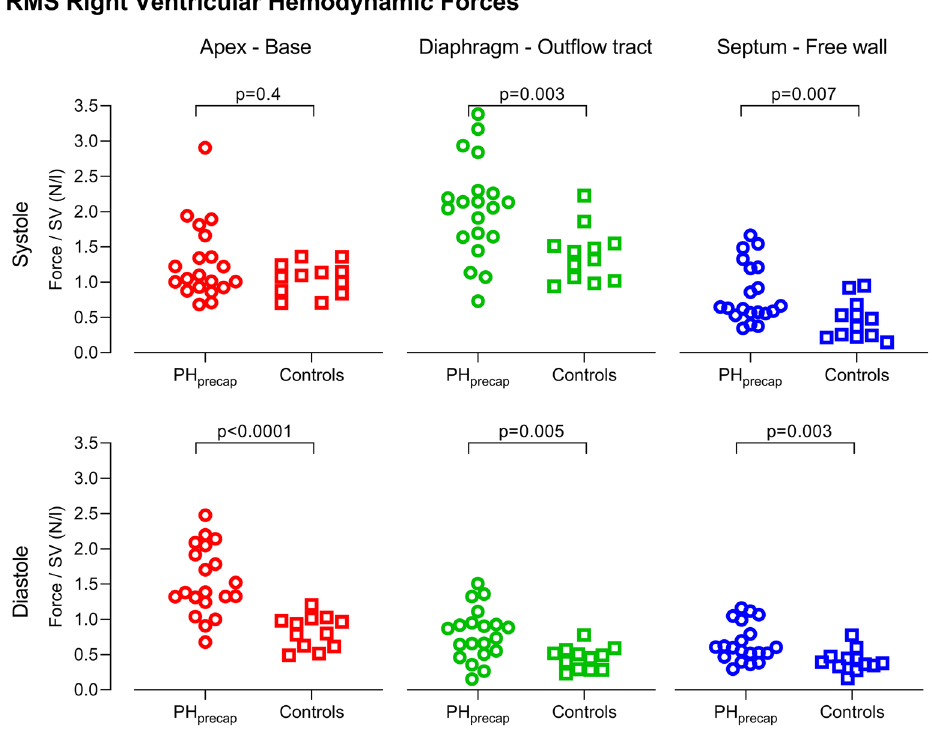
Figure 4. Root mean square (RMS) right ventricular hemodynamic forces in patients with precapillary pulmonary hypertension (PH precap , circles) compared to healthy controls (squares). RMS hemodynamic forces indexed to right ventricular stroke volume (SV) during systole (top row) and diastole (bottom row), in the apex- base direction (left column, red), diaphragm-outflow tract direction (middle column, green), and septum-free wall direction (right column,